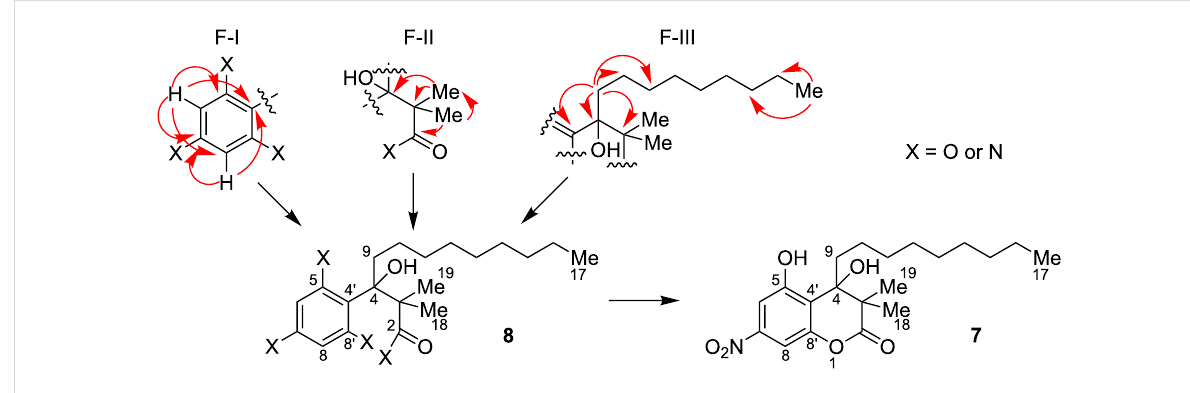
Figure 2: HMBC interactions used for the structure elucidation of myxocoumarin A ( 7 ).